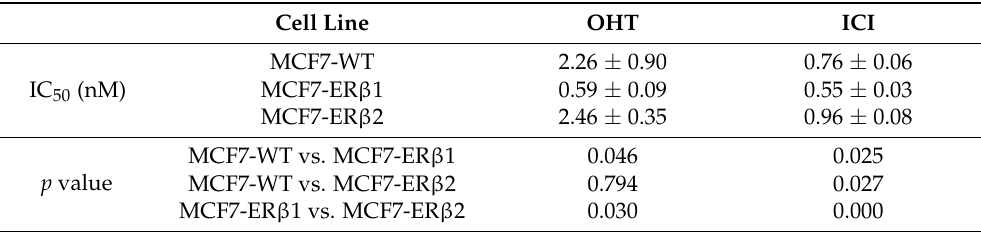
Table 1. IC 50 values of cell response to OHT or ICI as compared using one-way ANOVA. OHT, 4-hydroxytamoxifen; ICI, ICI182,780.